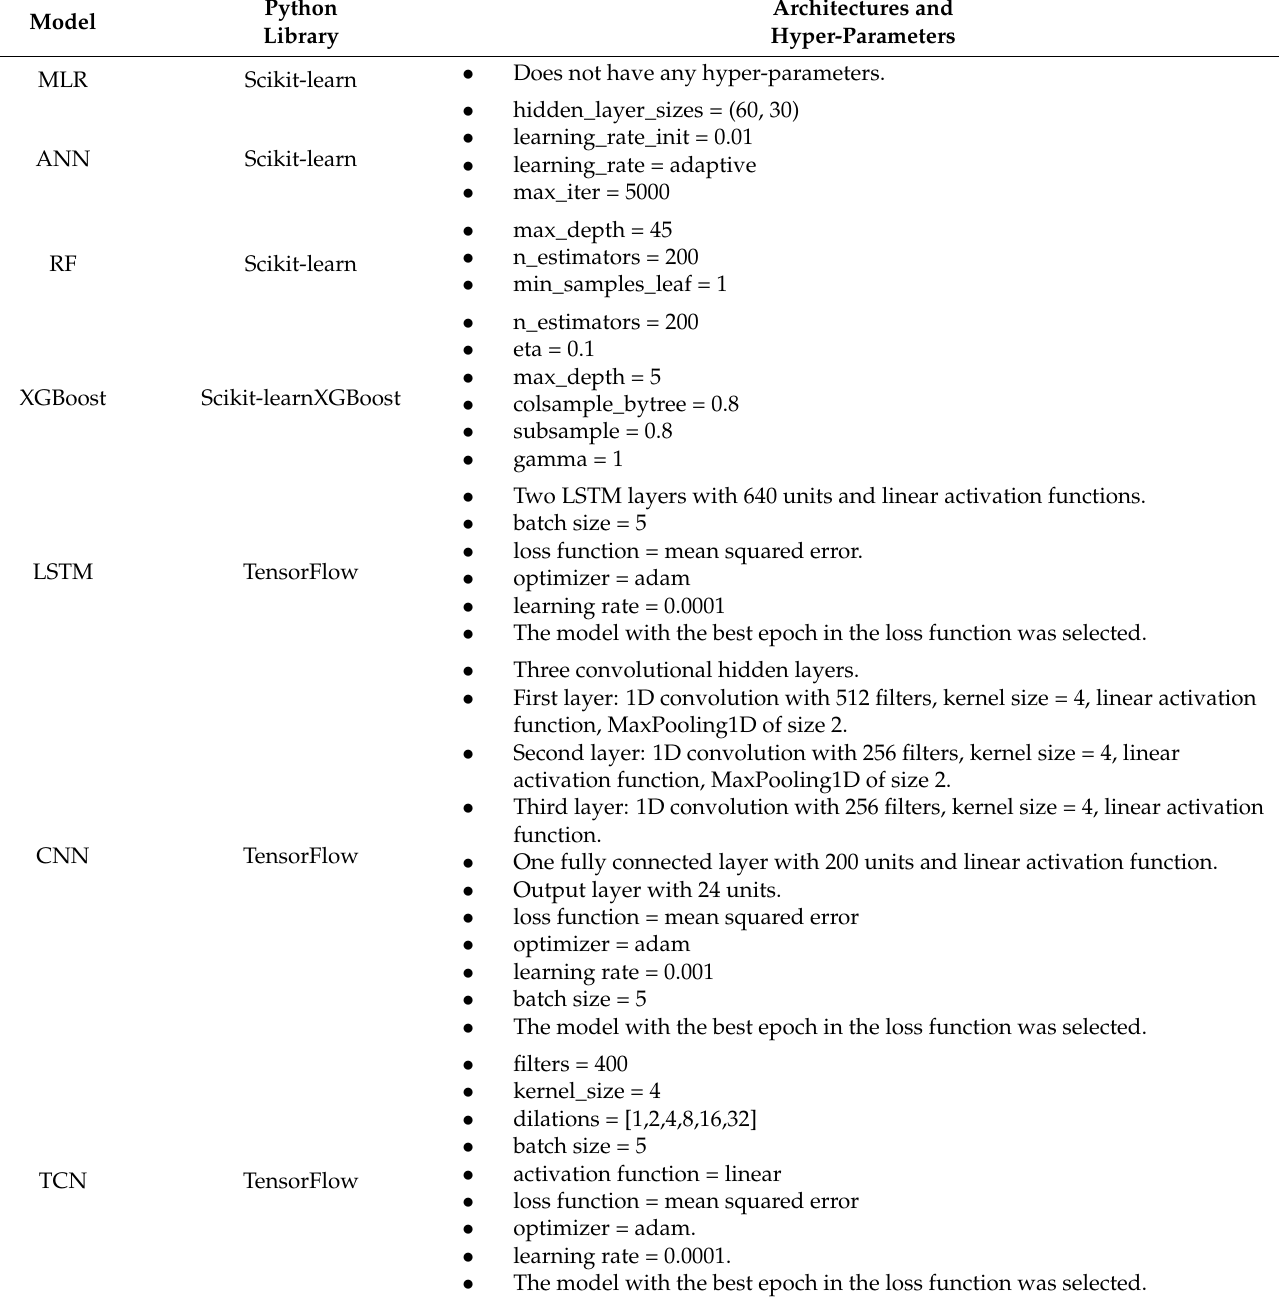
Table 1. Forecasting models architectures and